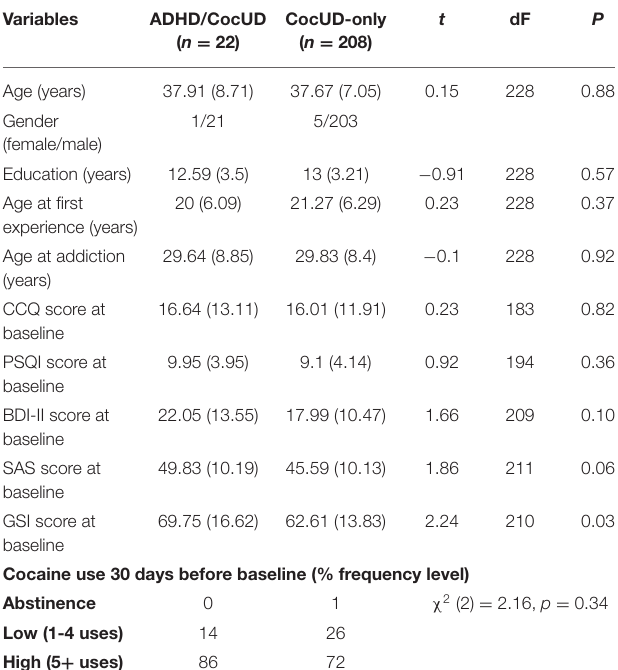
TABLE 1 | Demographic and clinical characteristics of